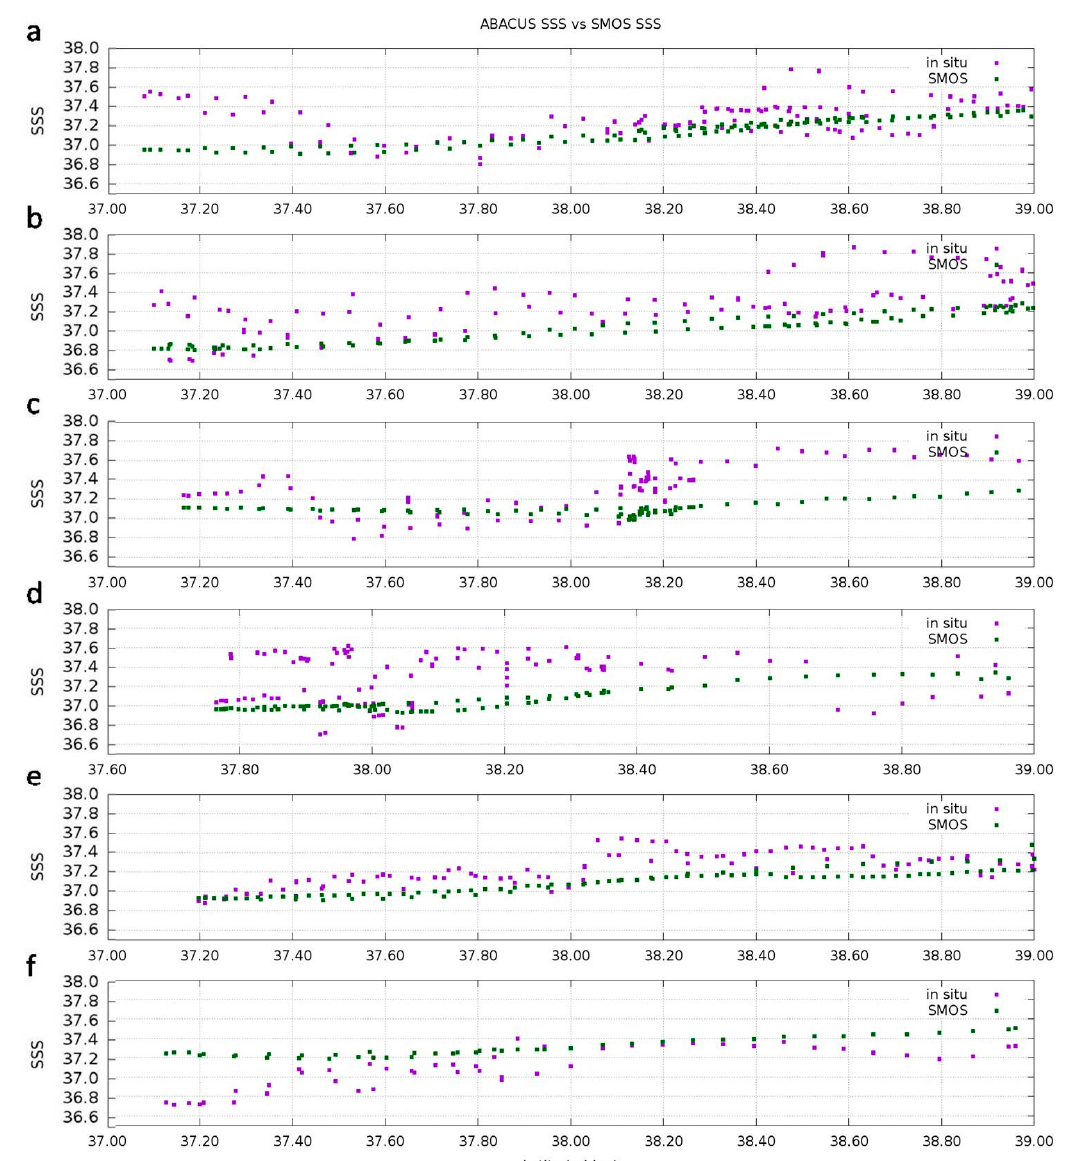
Figure 5. Comparison between averaged in situ glider salinities (purple dots) and SMOS L4 SSS (green dots) along latitude, during the missions ( a ) ABACUS 1.1 (Sept–Oct 201), ( b ) ABACUS 1.2 (Nov–Dec 201), ( c ) ABACUS 2.1 (Oct–Nov 2015), ( d ) ABACUS 2.2 (Nov–Dec 2015), ( e ) ABACUS 3.1 (Nov 2016), and ( f ) ABACUS 3.2 (Dec 2016).